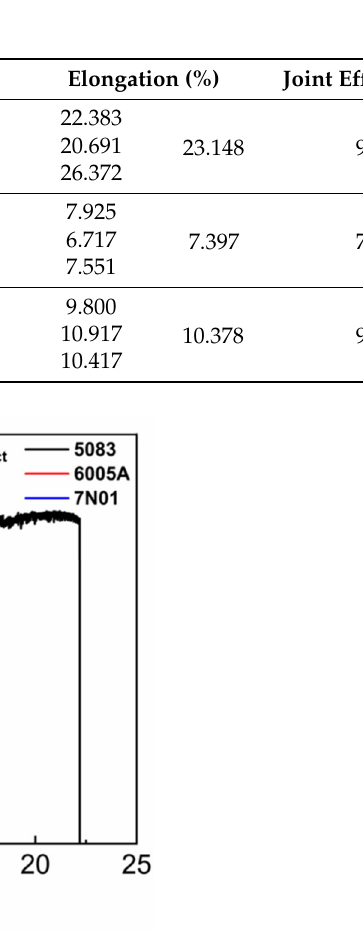
Figure 12. The displacement-strength curves of 5083, 6005A and 7N01 Al alloys welded joints.